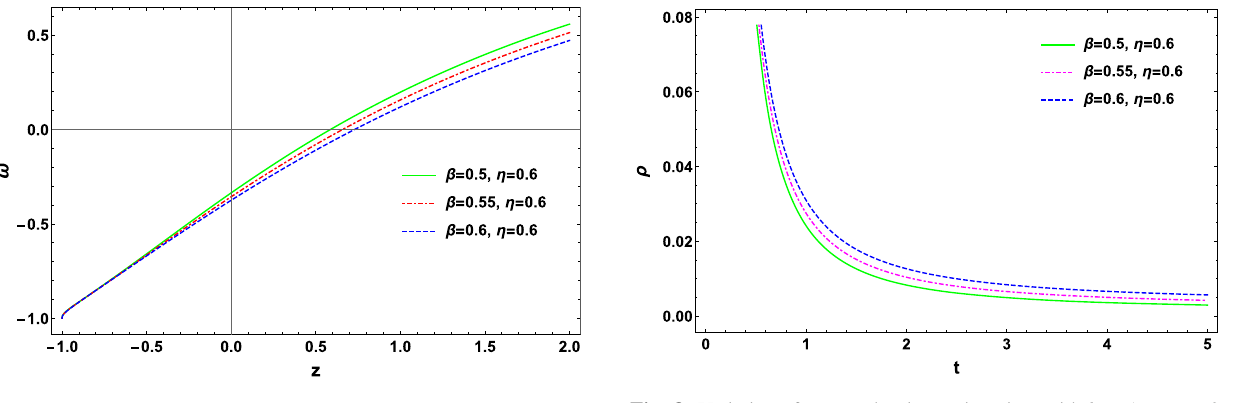
Fig. 7 Variation of EoS parameter against z with α = 0 . 2, μ = − 1, λ = − 8 ( t ) η kF 12 + (cid:7) (cid:8) 3 12 (λ + 4 π)(λ + 8 π) 2 (η + β t ) 2 − η